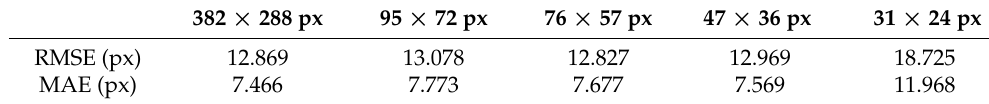
Table 1. Root mean square error (RMSE) and mean absolute error (MAE) for all